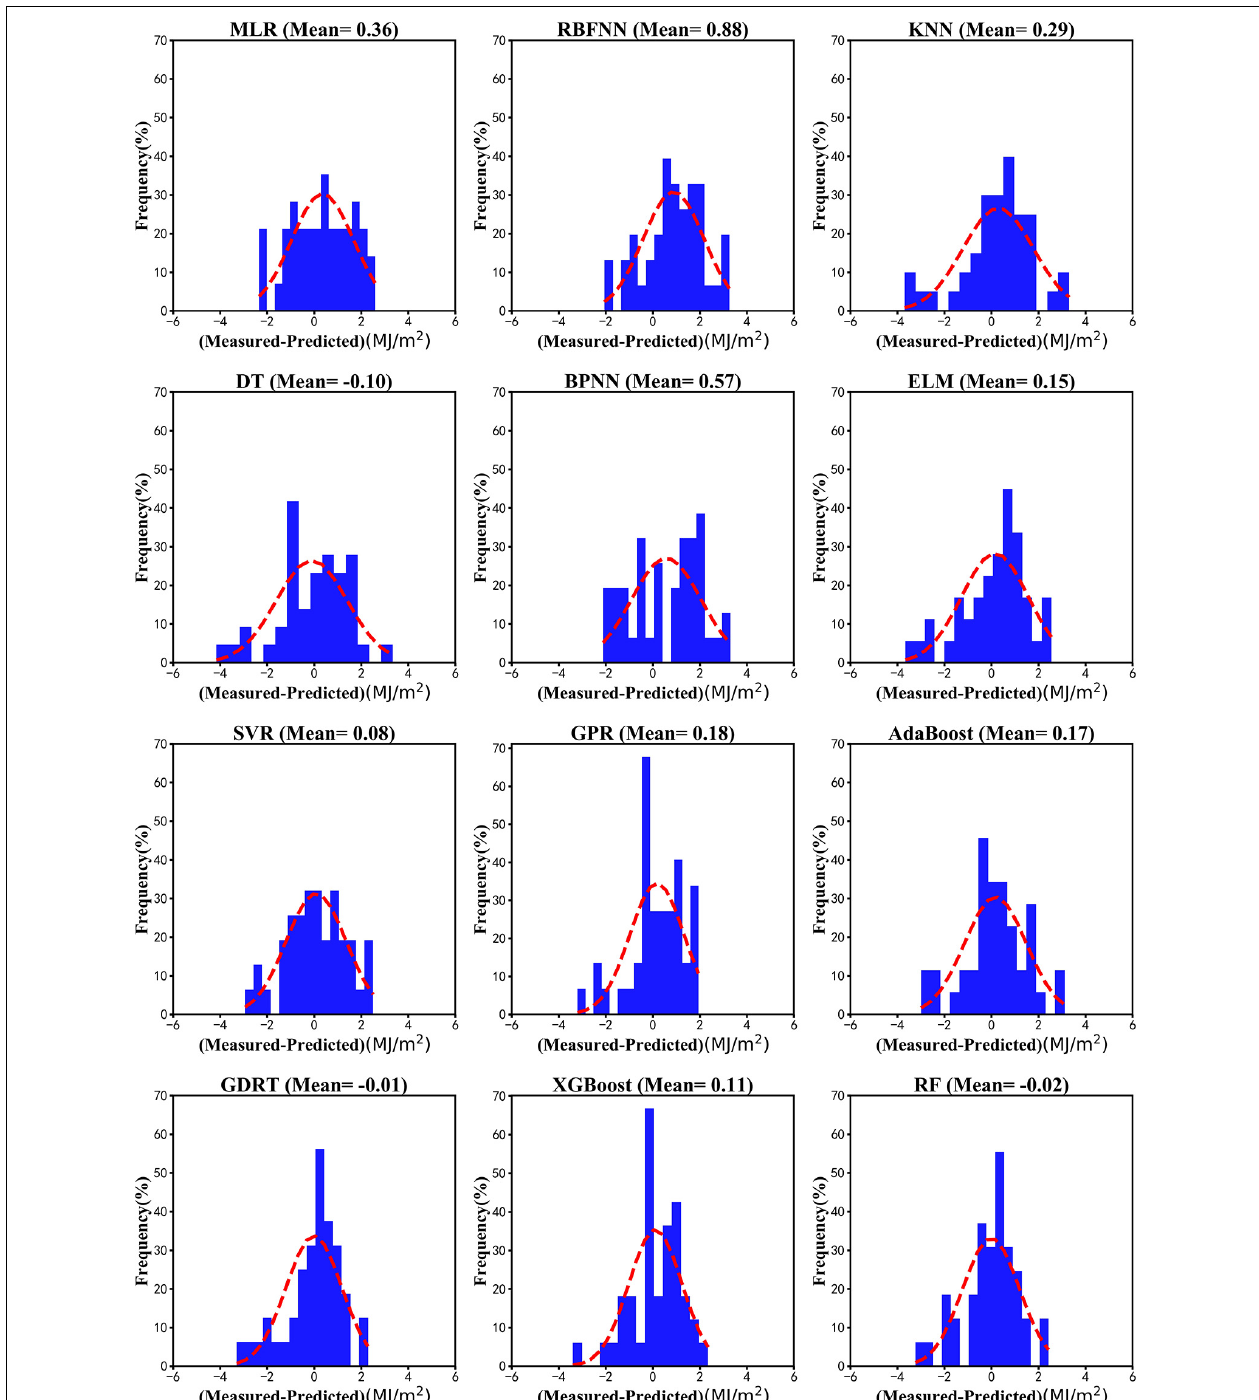
FIGURE 9 | Deviation distribution of machine learning models in predicting the monthly average solar radiation at Ganzhou from 1980 to 2016.